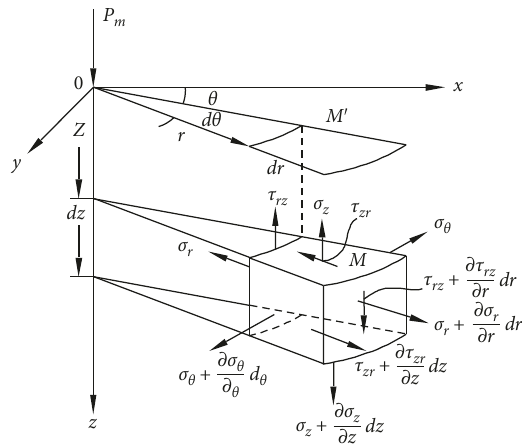
Figure 2: Stress analysis of the